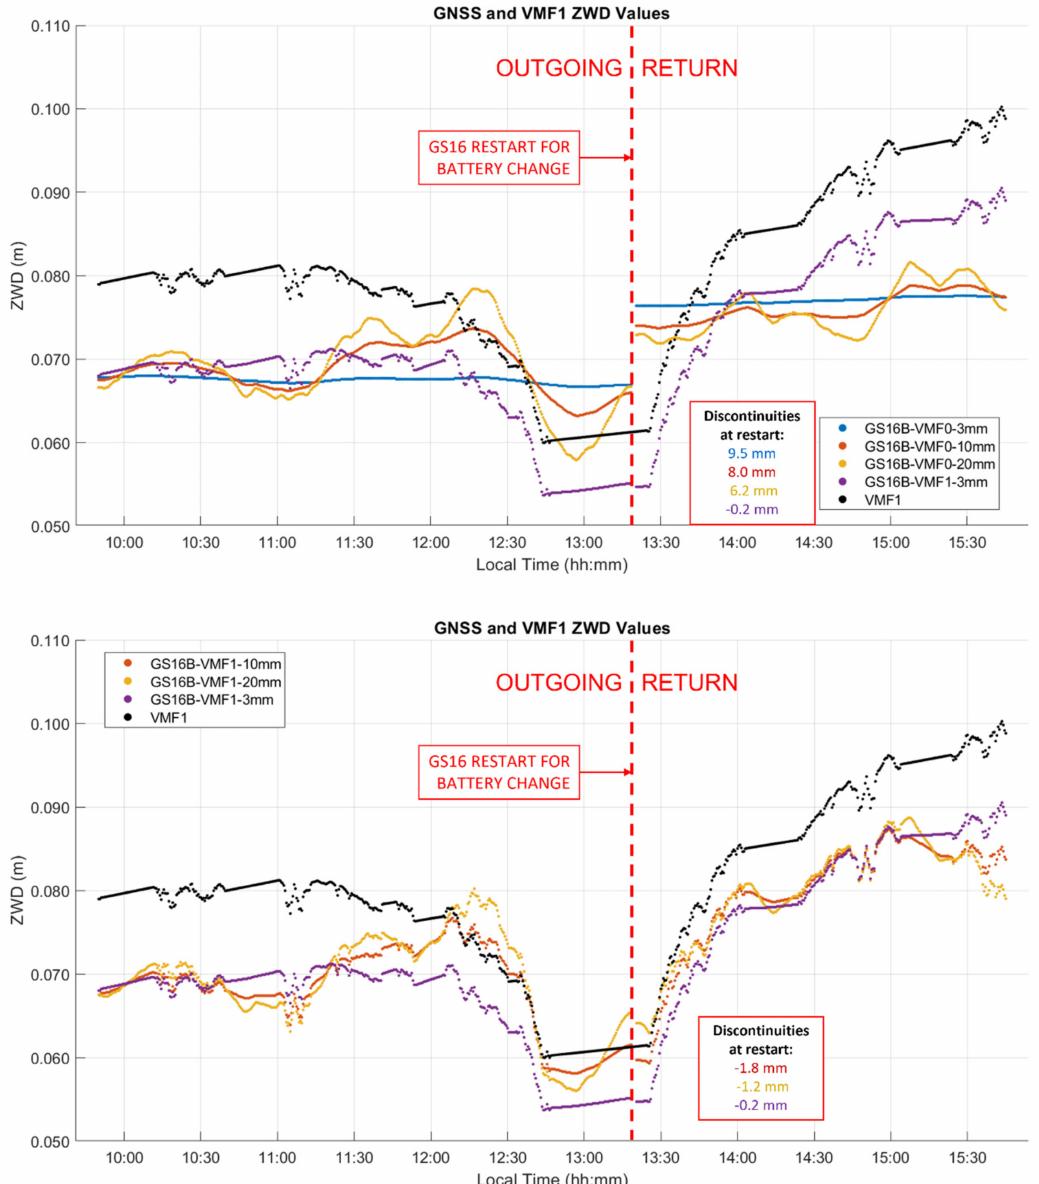
Figure 16. Kinematic dataset B GS16B receiver comparison of PPP ZWD solutions using a constant value of zero as the ZWD a priori input (upper plot, denoted as VMF0) and the VMF1 model as the ZWD a priori input (lower plot), with different levels of process noise. VMF1 model values and PPP solution using VMF1 model as a priori with 3 mm/ process noise are included in both plots. Local time is UTC −